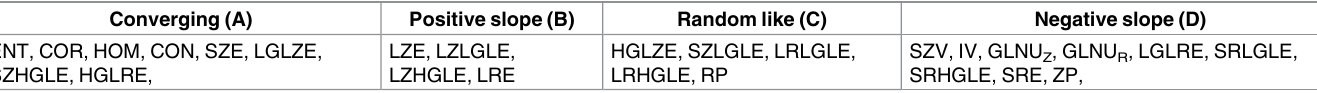
Table 3. The Classification of 26 Textural Indices According to the Kind of Dependency of Parameter vs. Volume. Converging